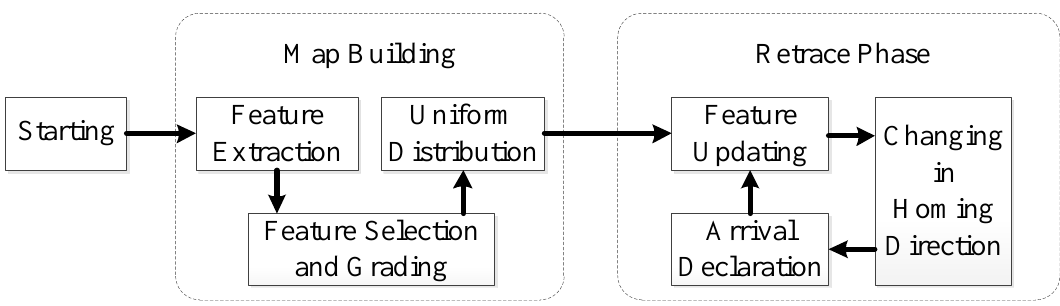
Figure 2. Outline of feature optimization